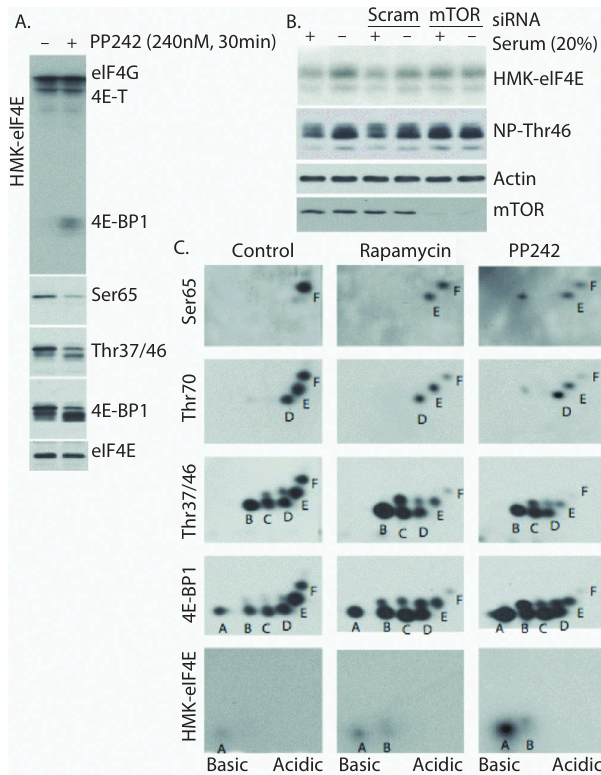
Figure 1. Analysis of eIF4E binding-competent forms of 4E-BP1. A ) PP242 treatment increases the eIF4E binding ability of 4E-BP1 and reduces 4E-BP1 phosphorylation. B ) Physiological treatment (serum starvation) modulates HMK-eIF4E binding ability of